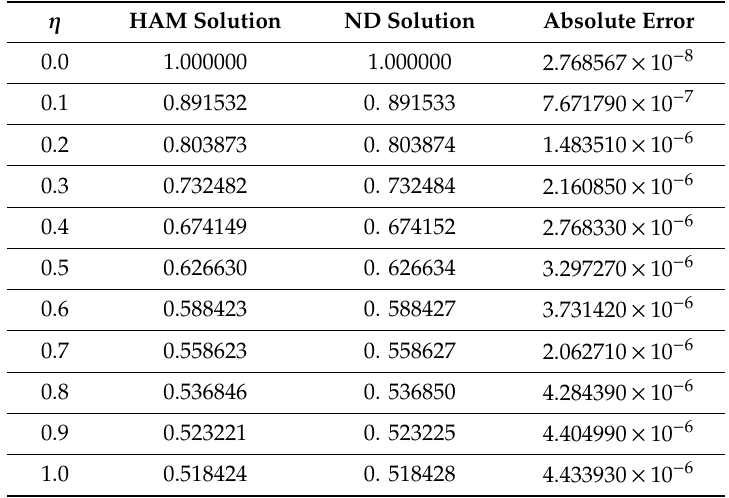
Table 3. The Comparison of HAM and ND-Solve for velocity function g ( η ) w.r.t di ff erent values of the dimensionless variable η